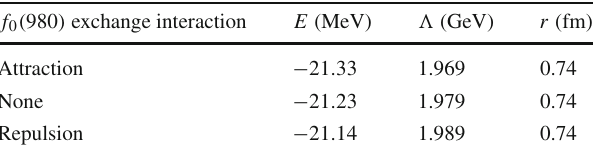
Fig. 1 Theboundstatesolutionsforthe D ∗ s ¯ D s 1 statewith J PC = 1 −+ . The left diagram is the r dependence of the OBE effective potentials with the cutoff (cid:10) = 1 . 97 GeV, and the right diagram is the cutoff dependence of the masses and the root-mean-square (RMS) radius with the S - D wave mixing analysis. [D] refers to the direct channel and [C] means the cross channel Table1 Thebindingenergyandroot-meansquareradiusforthe D ∗ s ¯ D s 1 state with J PC = 1 −+ with three different scenarios of the f 0 ( 980 ) exchange interaction